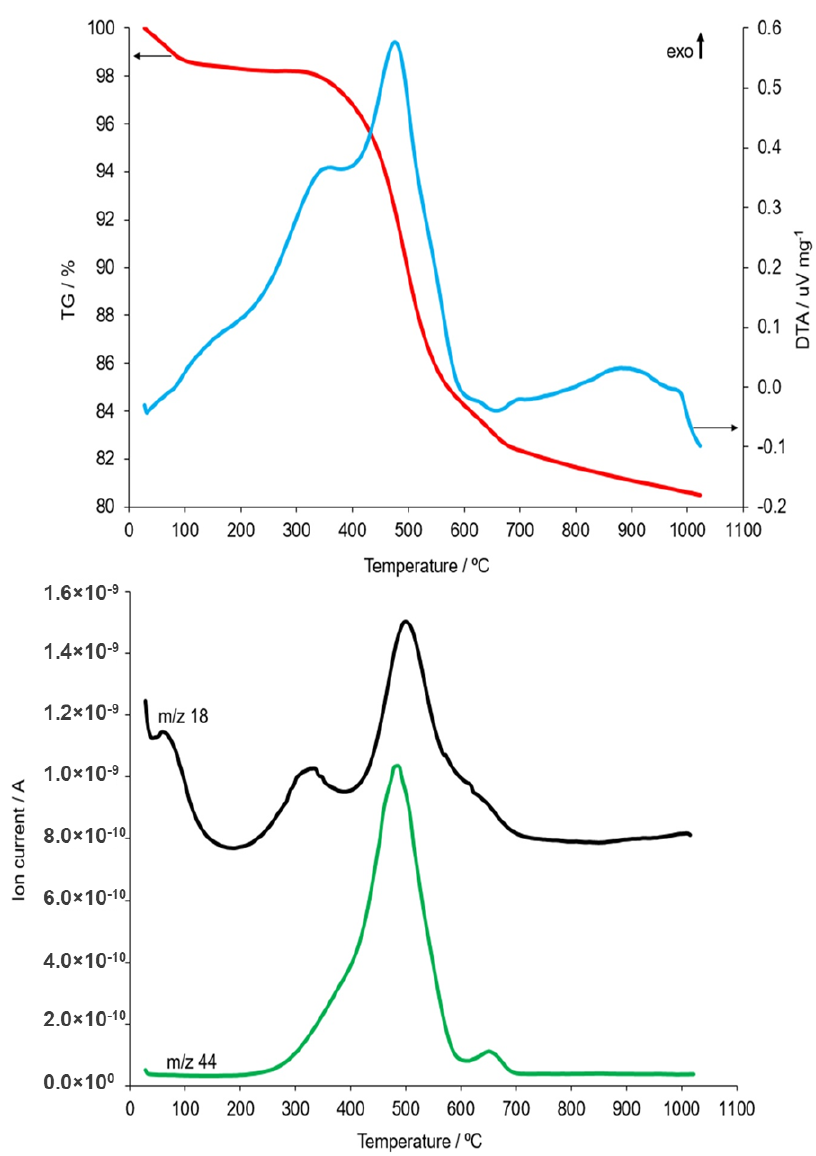
Figure 2. TG, DTA and MS curves (changes in content: H 2 O— m/z 18 and CO 2 — m/z 44) recorded during heating from ambient temperature up to 1000 °C of R2 sample taken from the Ruch Rydułtowy hard coal mines.